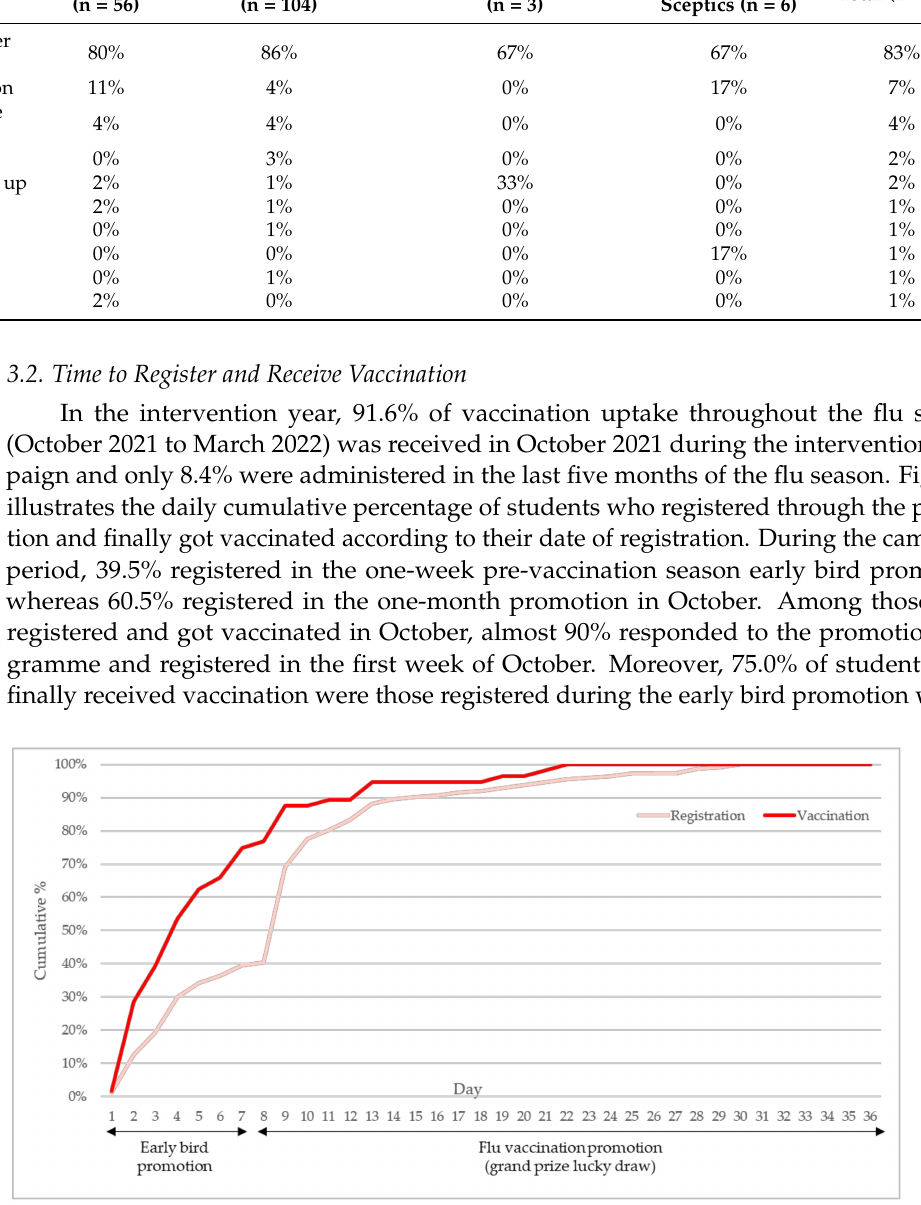
Figure 4. Cumulative percentage of registration by